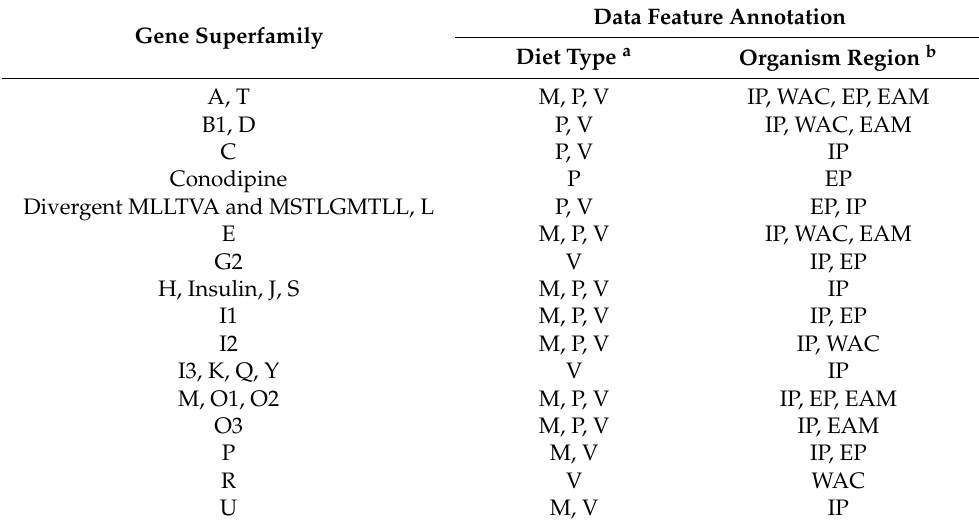
Table 1. Gene superfamily features.